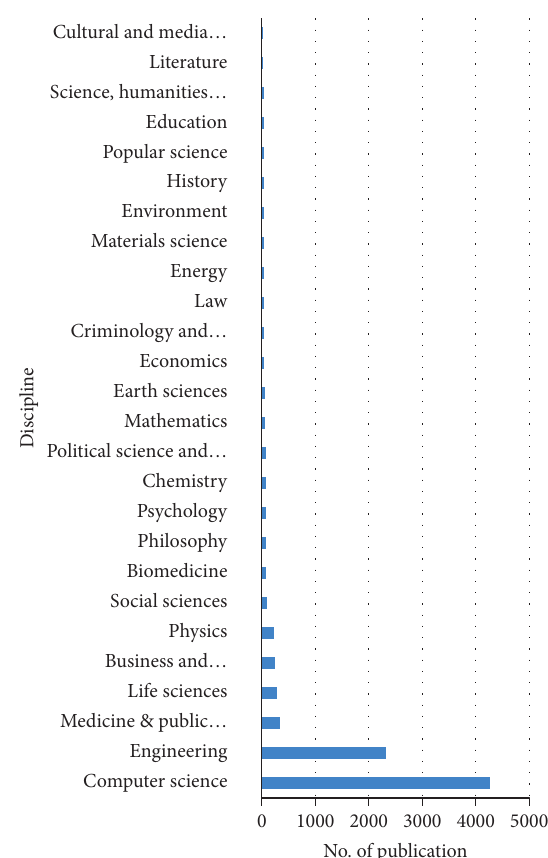
Figure 13: Content type and number of